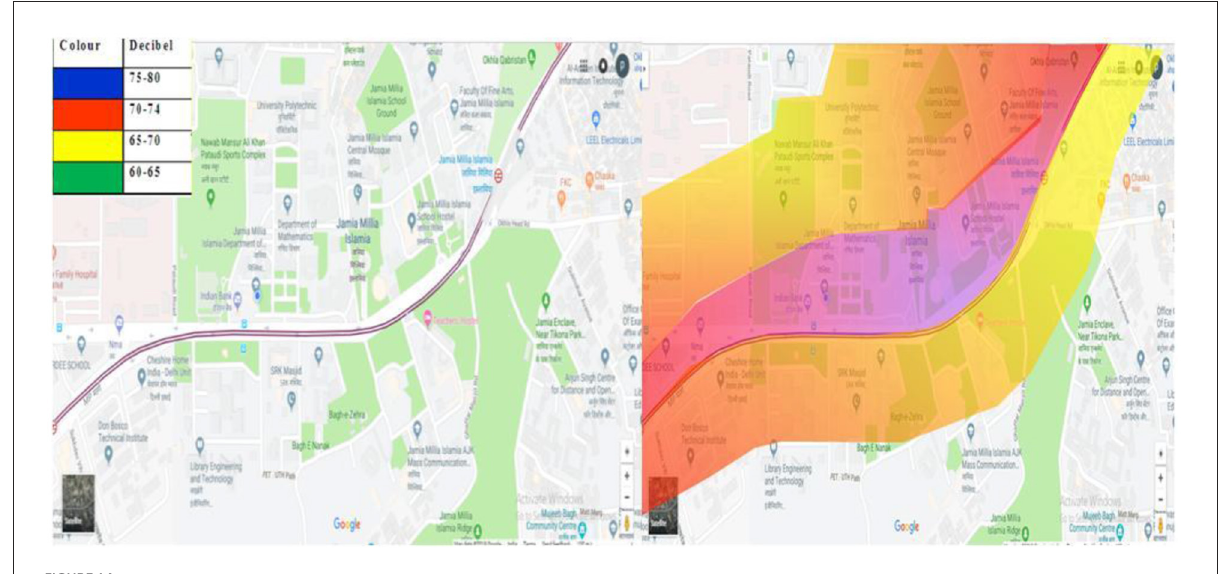
FIGURE14 2D noise mapping of silent